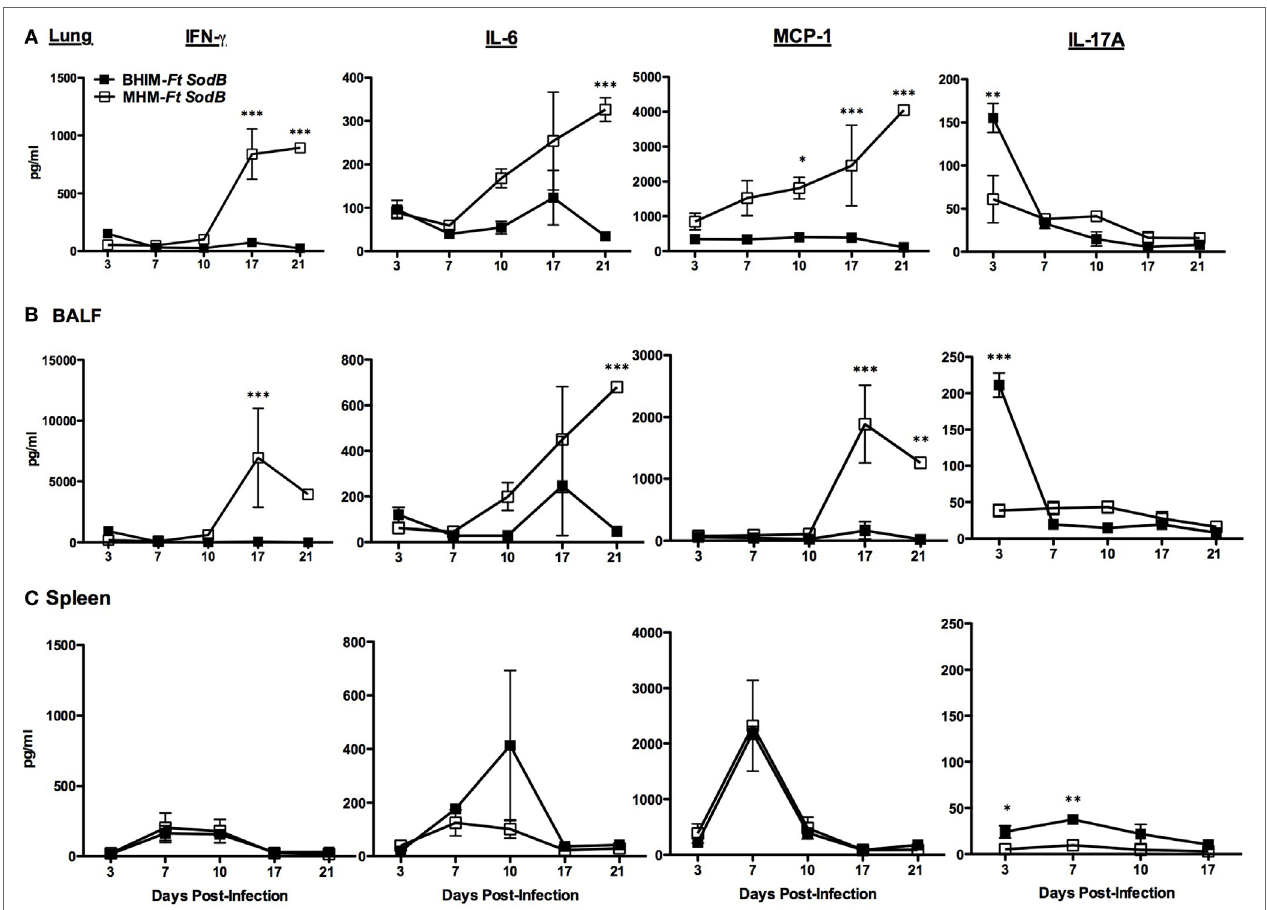
FigUre 5 | Brain-heart infusion medium (BHIM)- Francisella tularensis ( Ft ) sodB -vaccinated mice exhibit reduced Ft SchuS4-induced inflammation. C57BL/6 female mice were immunized with BHIM or Mueller-Hinton medium (MHM)- Ft sodB and challenged as described in Figure 4 . The levels of pro-inflammatory cytokines from lung tissue homogenates (a) , BAL fluid (B) , and spleen homogenates (c) were determined on indicated days post-challenge. The values represent the average count of three mice sacrificed at each time point ± SD and are from a single experiment. Similar results were obtained in two independent experiments. * p < 0.05, ** p < 0.01, and *** p <